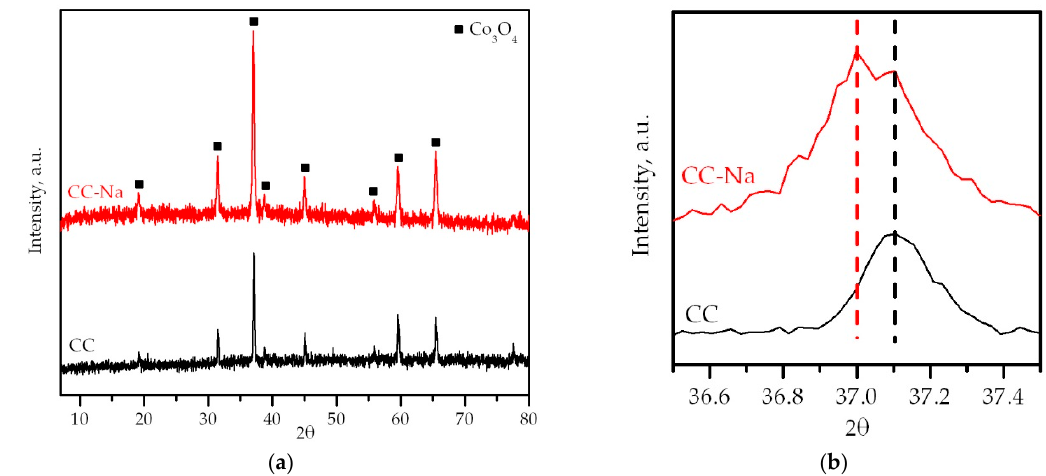
Figure 2. ( a ) XRD diffractograms of the catalysts; ( b ) detail of the most intense diffraction signal.